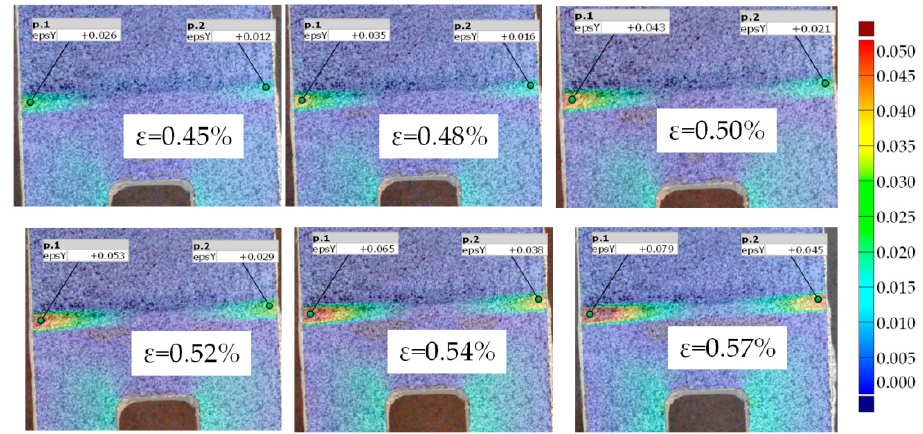
Figure 17. Distribution of strain on surface for sample no. 5 with rectangular holes with a fillet radius R2 and composite overlays for strain: ( a ) ε TOT = 0.42%; ( b ) ε TOT = 0.48%; ( c ) ε TOT = 0.52%; ( d ) ε TOT = 0.57%.